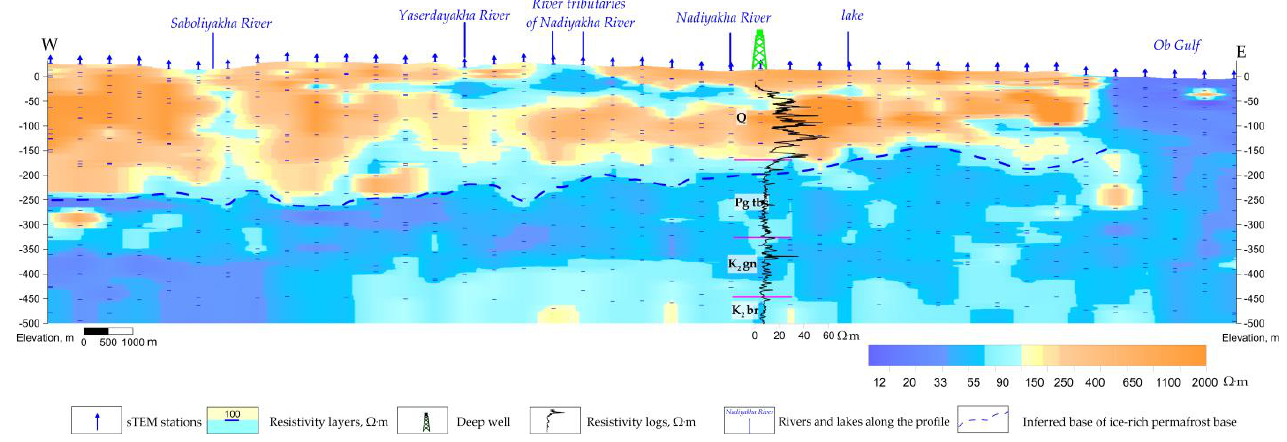
Figure 10. Example resistivity cross-section for the Yamal Peninsula [2].